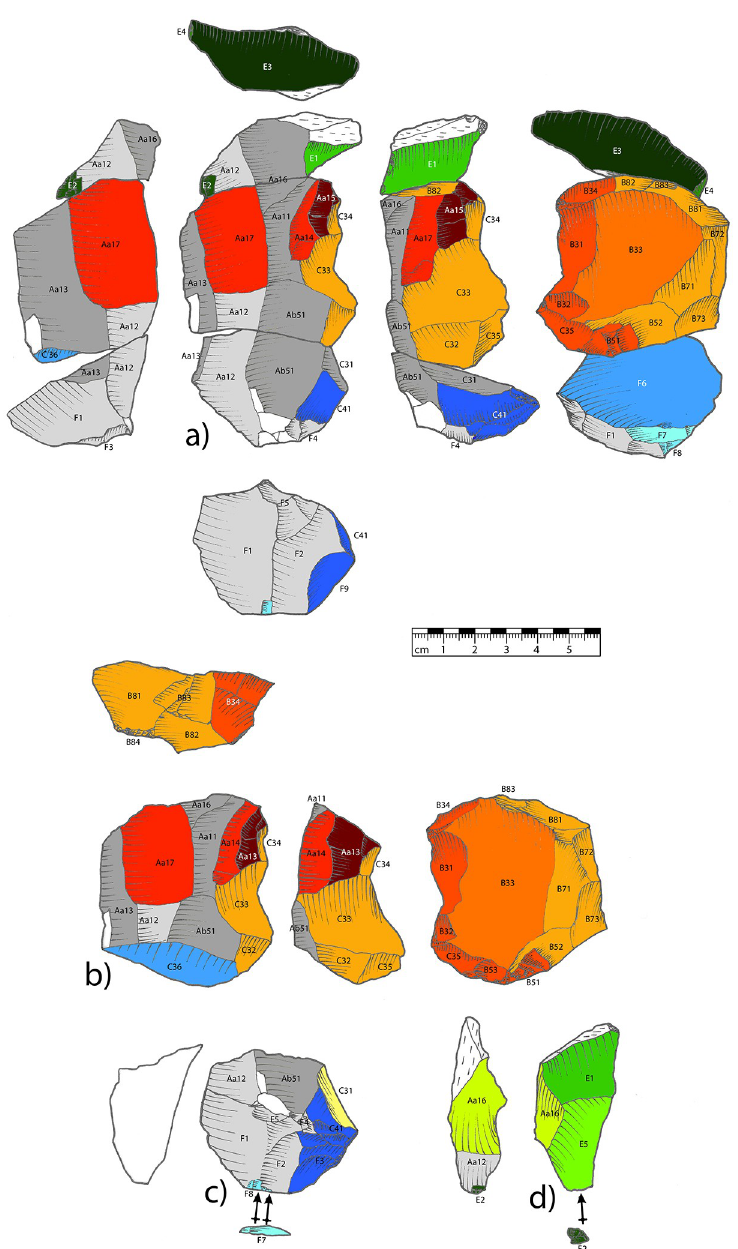
Fig 5. Drawing of the refitted reduction sequence. Legend: a) drawing of the three pieces, refitted; b) blade/Levallois core of the middle volume; c) core cap of the lower volume and d) core-edge blank of the upper volume. The bluish, reddish and greenish colored areas correspond to the working steps in Fig